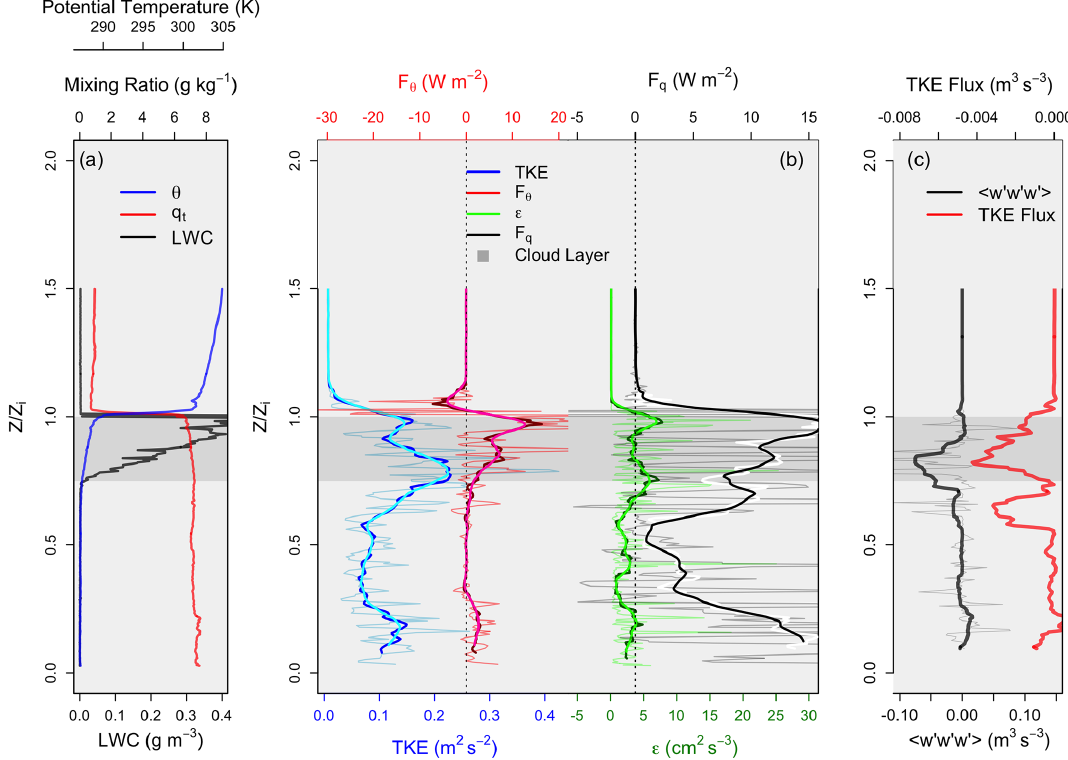
Figure 13. As in Fig. 12, except for the well-mixed boundary layer case of RF3 (19 October). Panel (c) provides a profile of TKE flux (m 3 s − 3 ) as opposed to N and average drop